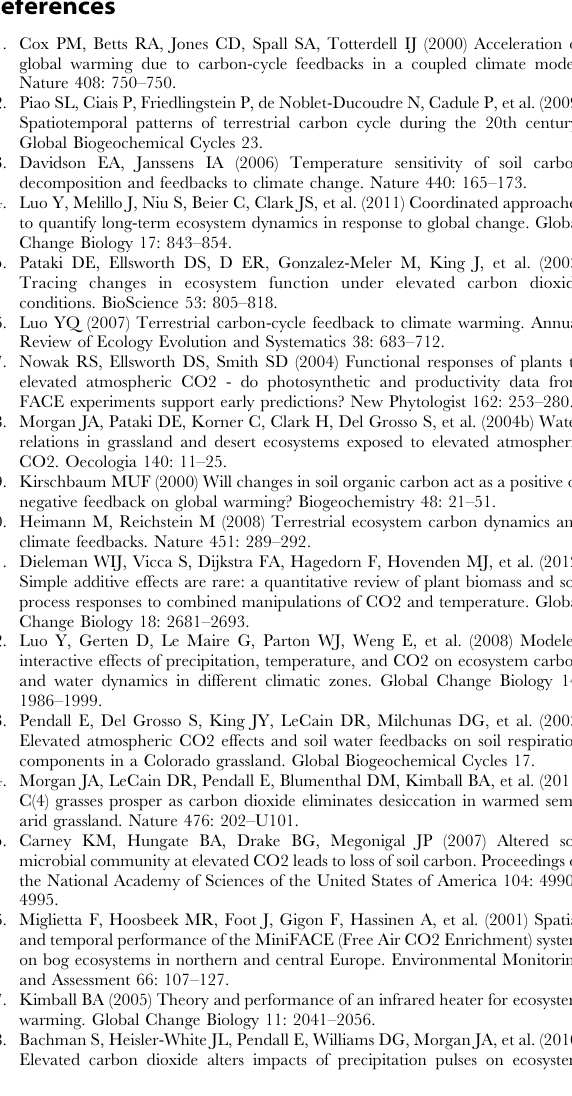
Figure S1 Relationship between midday and daily measurements of ecosystem respiration. Individual data points reflect pairs of midday measurements and daily sums for a given treatment during diurnal field campaigns conducted in 2007–2010. Figure S2 Relationship between midday and daily measurements of ecosystem photosynthesis. Individual data points reflect pairs of midday measurements and daily